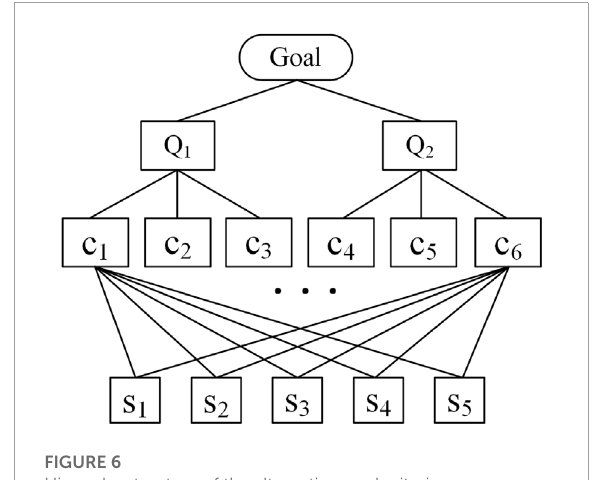
FIGURE 6 Hierarchy structure of the alternatives and criteria.